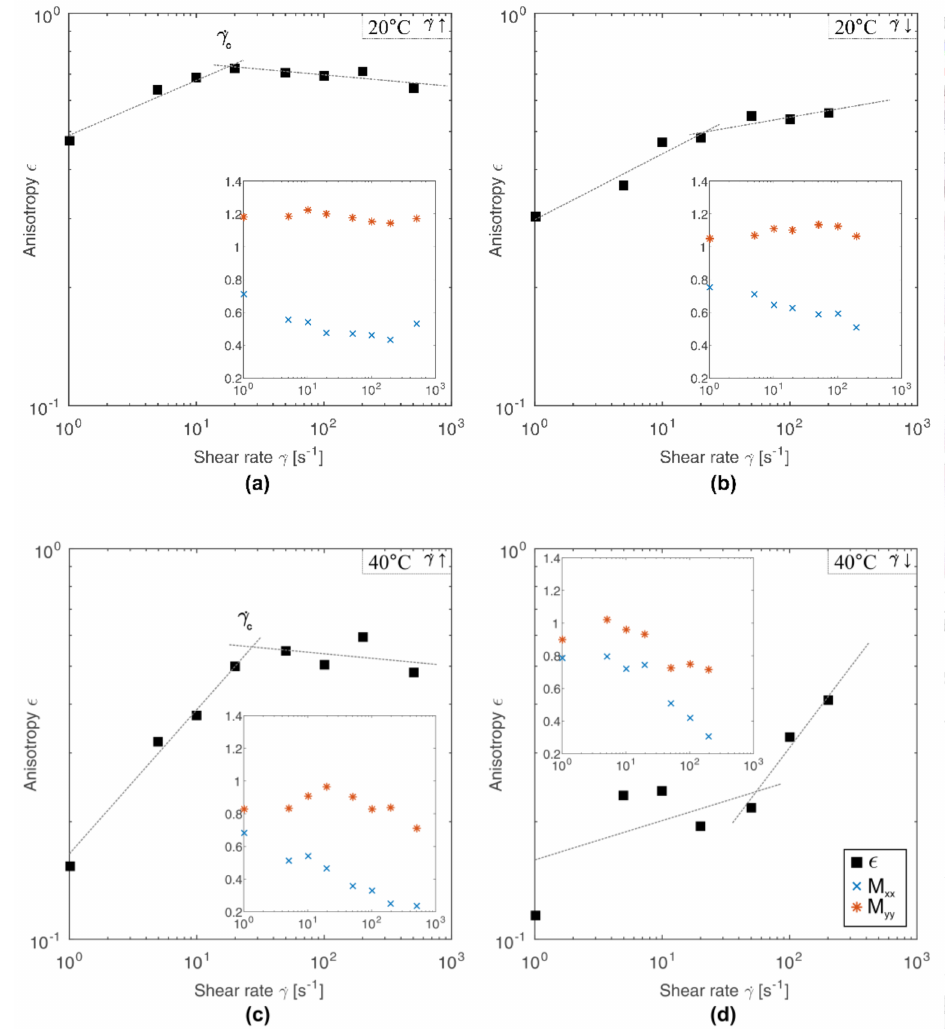
Figure 3. Changes in anisotropy (cid:15) as a function of shear rate. The inner plot show changes in the second-order tensors M xx and M yy as a shear rate function. Measurements were made for increasing ( ˙ γ ↑ ) and decreasing ( ˙ γ ↓ ) shear